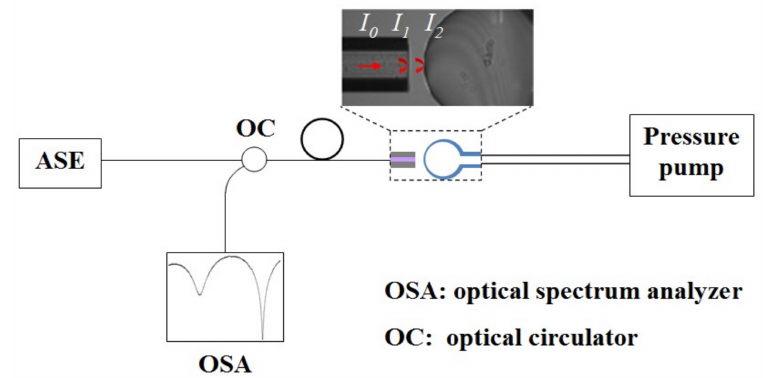
Figure 5. Experimental setup for measuring the pressure sensitity of the fabricated single-ended microbubble.